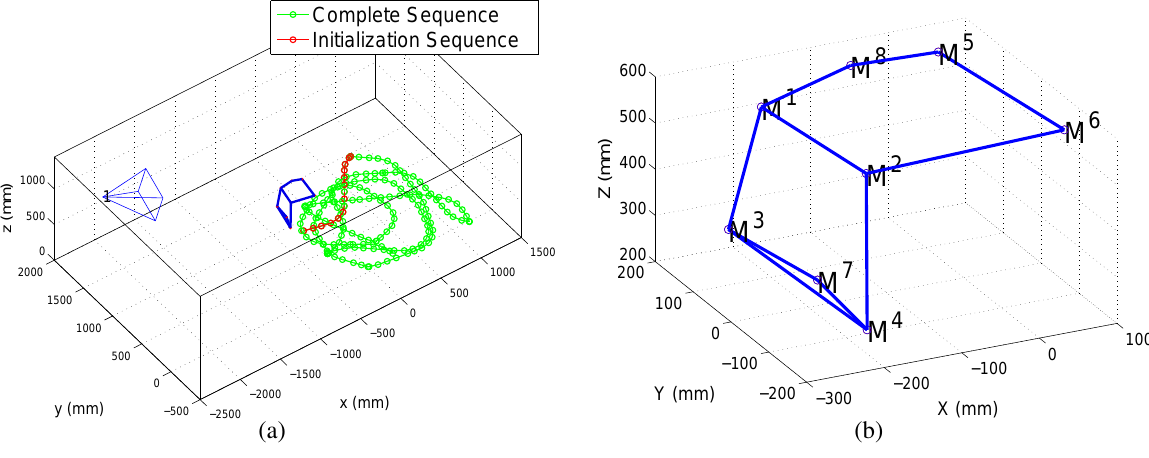
Figure 14. Scene geometry and 3D model obtained during